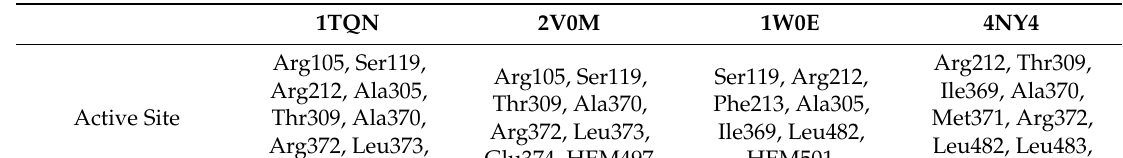
Table 4. Analysis of the active site in CYP3A4 (using di ff erent PDB IDs) after interaction with aflatoxin AFB1, provided by molecular docking simulations.